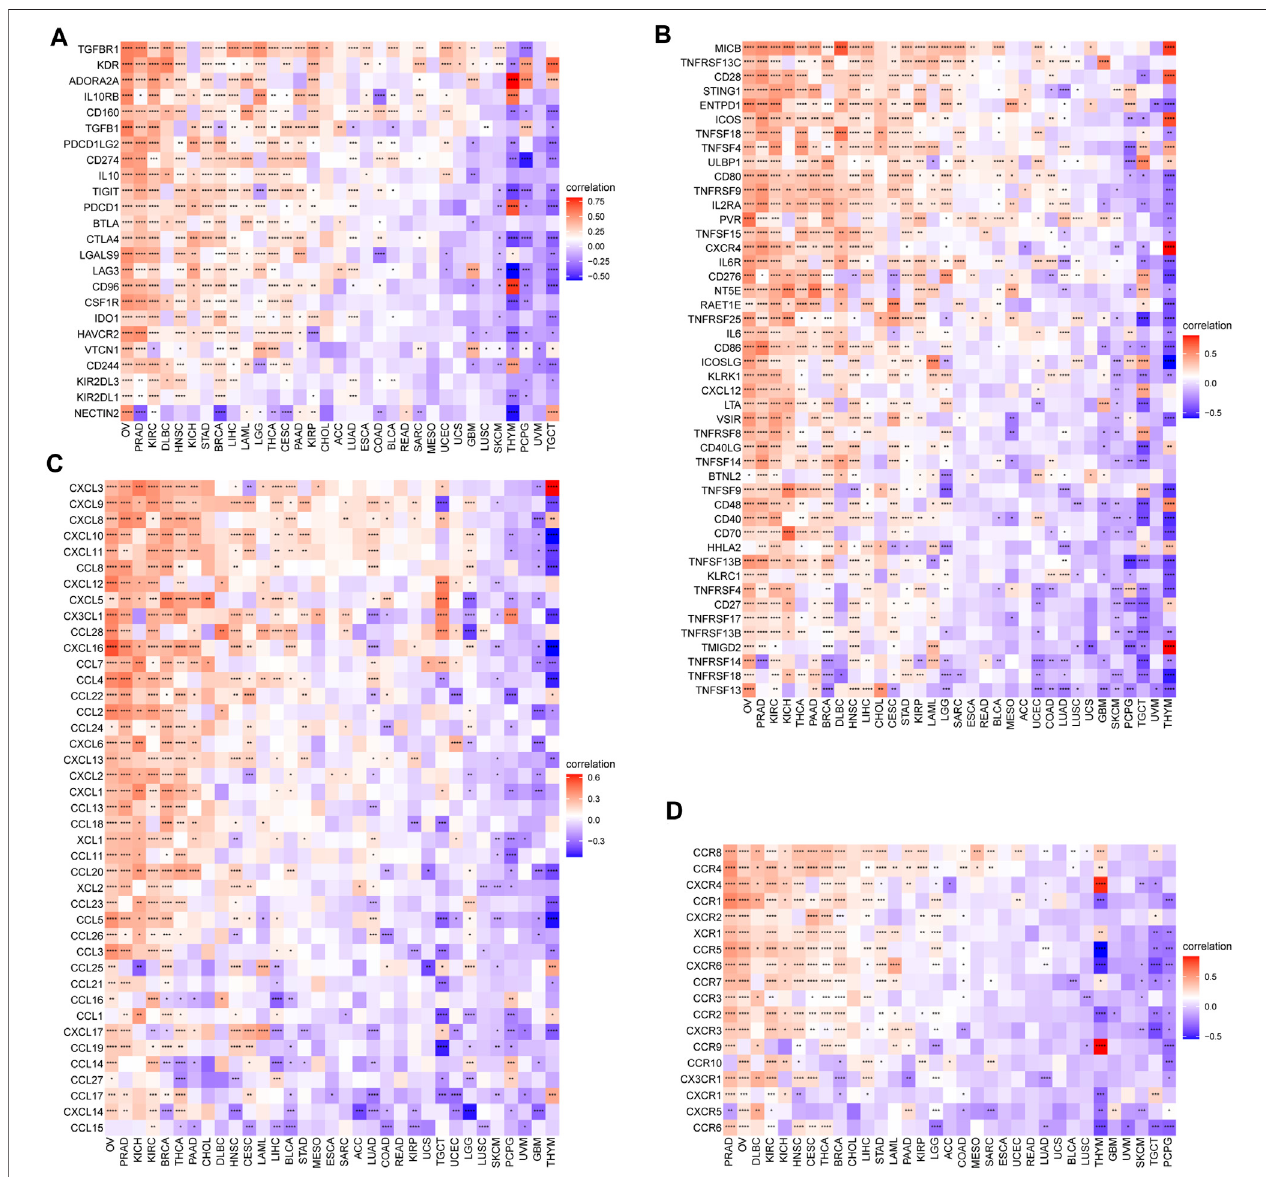
FIGURE 12 | The association between senescence score (SS) and immune-associated genes. (A) Correlations between SS and immunosuppressive genes encoding immune suppression. (B) CorrelationsbetweenSS and immune-activatedgenesencoding immune activation. (C) Correlations betweenSSand chemokines. (D) Correlations between SS and chemokine receptors. Red represents a positive correlation and blue represents a negative correlation. Darker color represents stronger correlations (Spearman correlation, p < 0.05 was considered signi fi cant, * p < 0.05, ** p < 0.01, *** p < 0.001, and **** p <